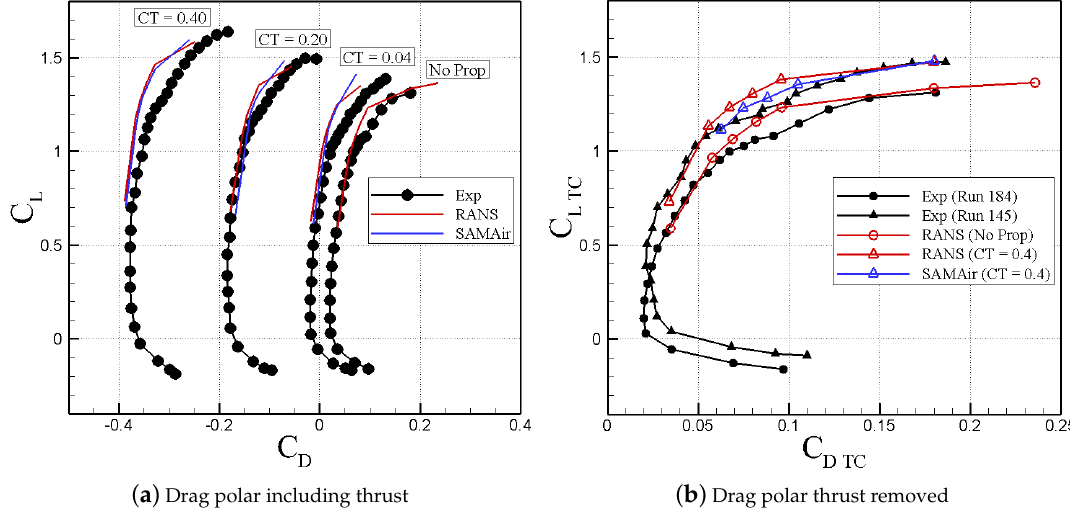
Figure 14. Drag polar plots for isolated wing and the wing propeller at different propeller spin